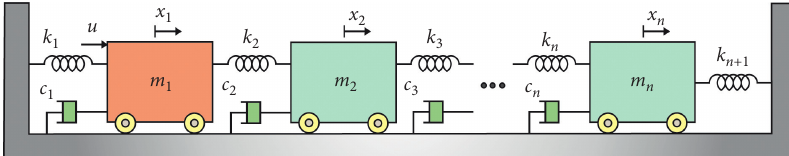
Figure 1: Schematic diagram of a n DOF flexible mechanical